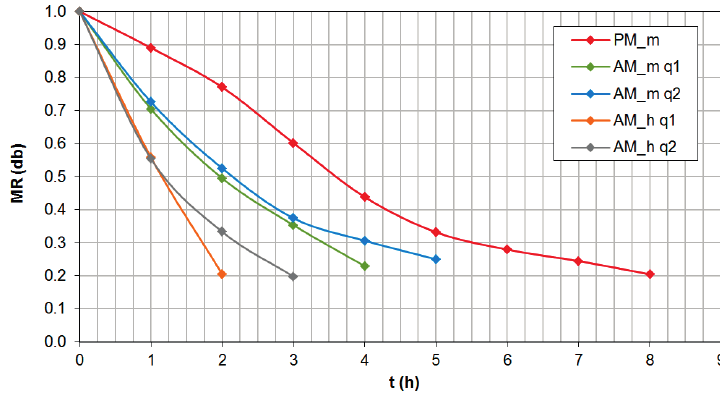
Figure 5. Influence of air mass flow on olive pomace (OP) drying.